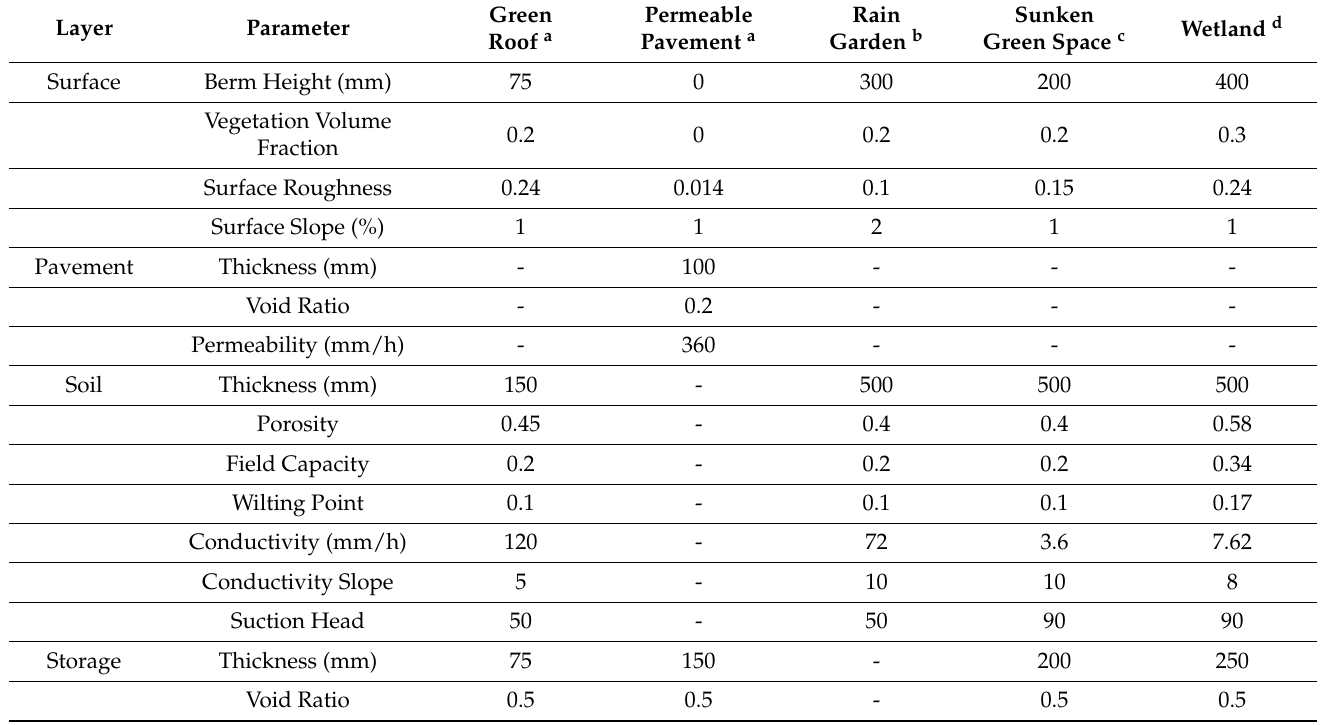
Table 2. SMWW parameters used for the simulations of Scenario 2. Data from [32] a , [33] b , [34] c , [35] d